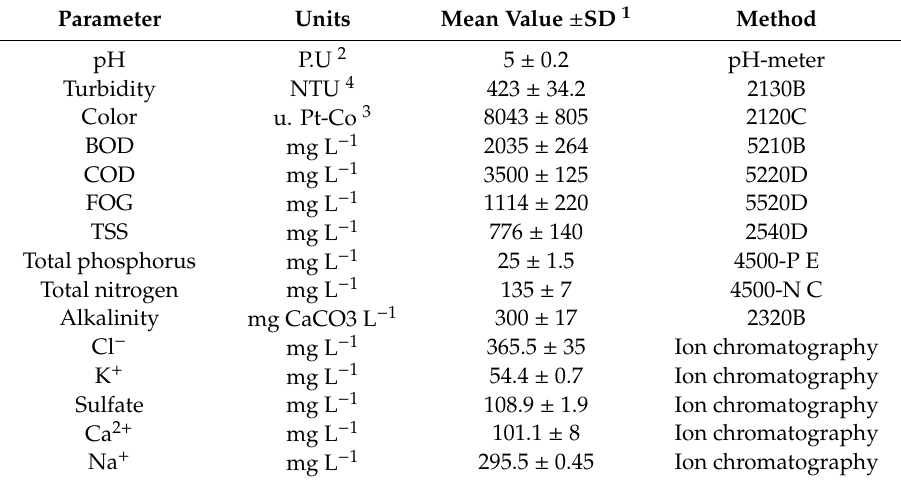
Table 2. Physicochemical characterization of cold meat industry wastewater